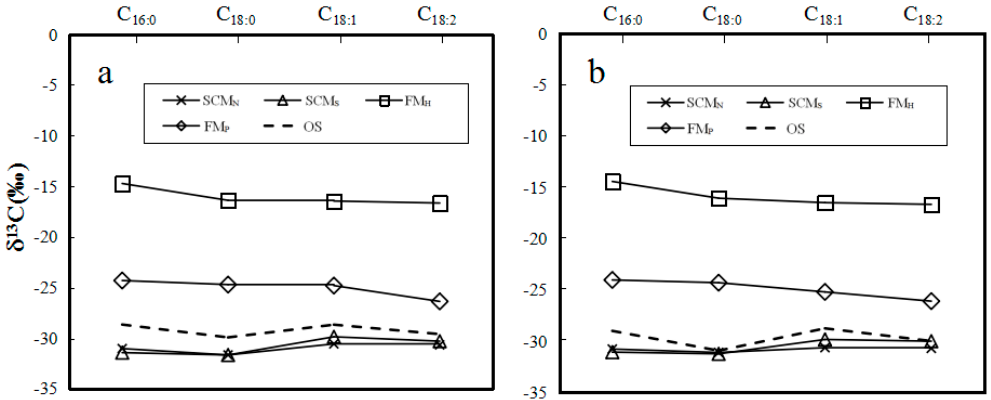
Figure 8. Variation of the δ 13 C values of major fatty acids C 16:0 , C 18:0 , C 18:1 , and C 18:2 in the neutral ( a ) and polar ( b ) lipids from the common substitutes of Ophiocordyceps sinensis. SCM N and SCM P , the cultivated stromata of Cordyceps militaris ; FM H , the fermented mycelia of Hirsurella sinensis ; FM P , the fermented mycelia of Paecilomyces epiali ; OS, wild Ophiocordyceps sinensis .